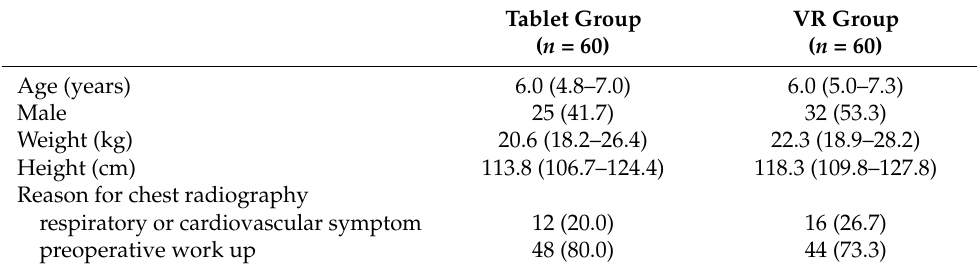
Figure 3. CONSORT Flow Diagram. VR, virtual reality. Table 1. Patients’ characteristics.